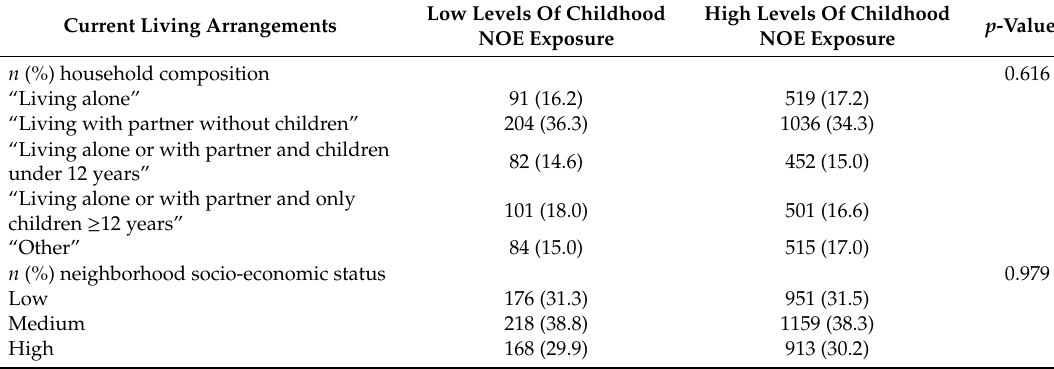
Table 5. Current living arrangements of the study population on pooled level for subgroups with di ff erent amount of childhood NOE exposure (low levels and high